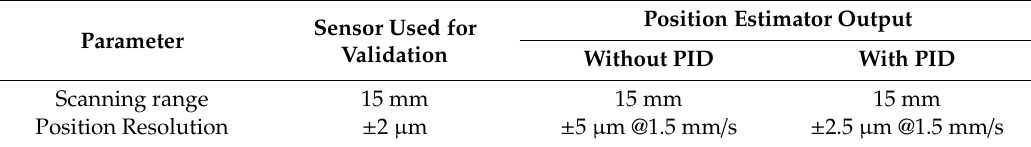
Table 4. Summary of achievements of the position estimator